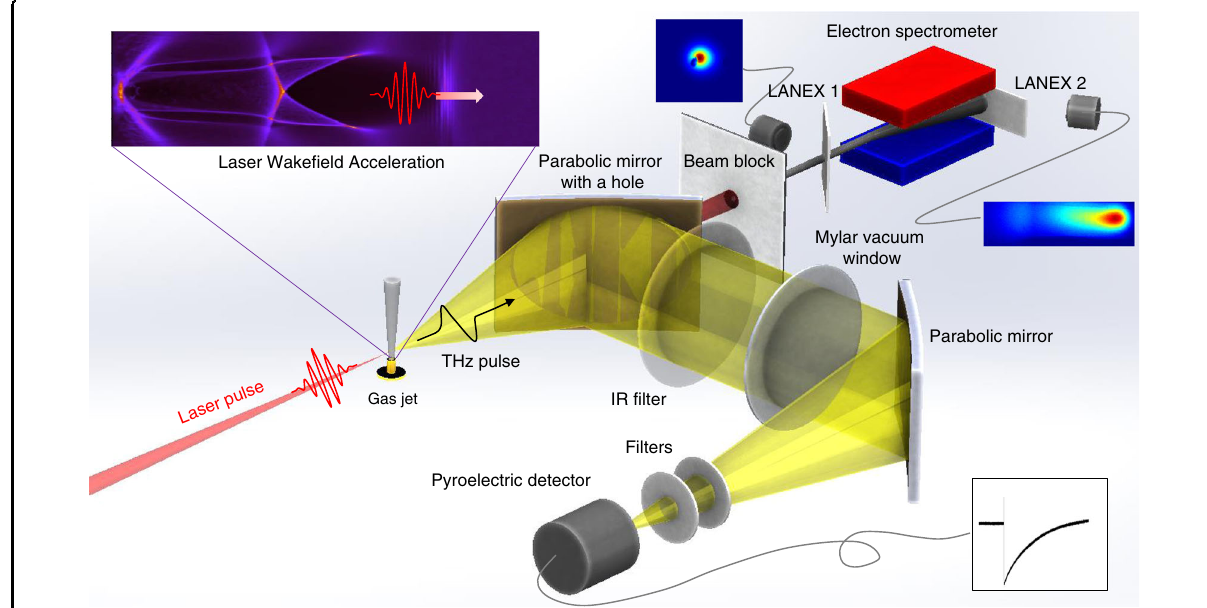
Fig. 1 Schematic of laser-driven electron acceleration and THz generation. The laser pulse ionizes a gas jet and accelerates plasma electrons via LWFA, simultaneously generating THz radiation. The electron beam diagnostics include scintillating screens — Lanex 1 for beam pro fi ling and Lanex 2 for measuring the electron energy spectrum after the beam passes through an electron spectrometer with a 1-T dipole magnet. THz radiation emitted from the plasma is collimated, transported outside the vacuum chamber, and then refocused onto a pyroelectric detector for